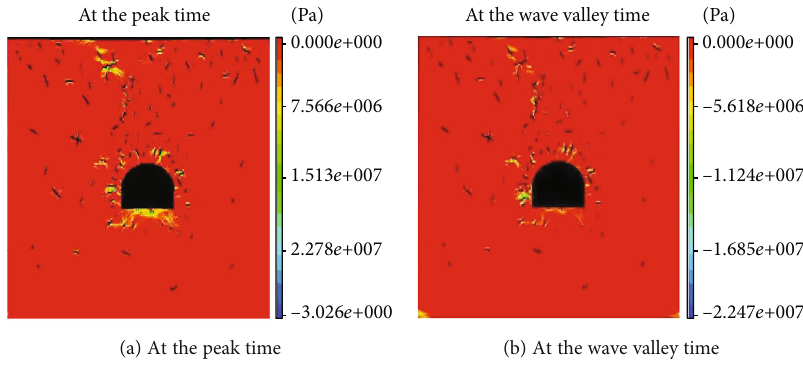
Figure 10: Minimum principal stress evolution process in the fi rst